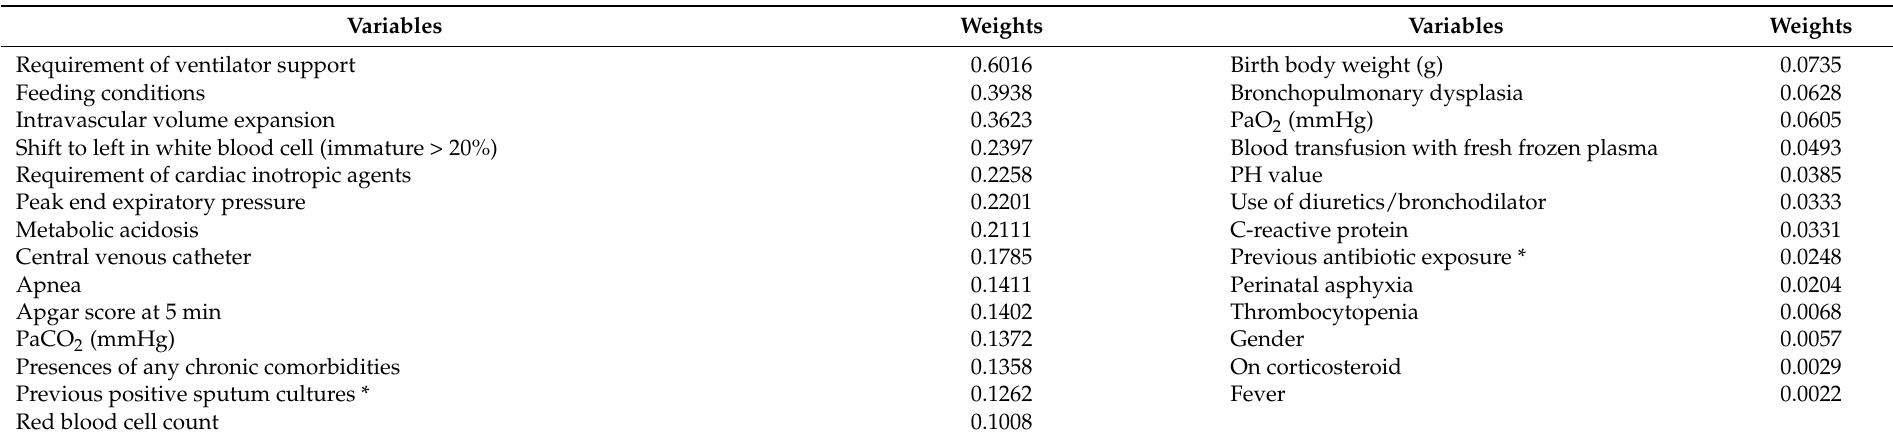
Table 3. The weights and importance of each covariate in the development of the final predictive